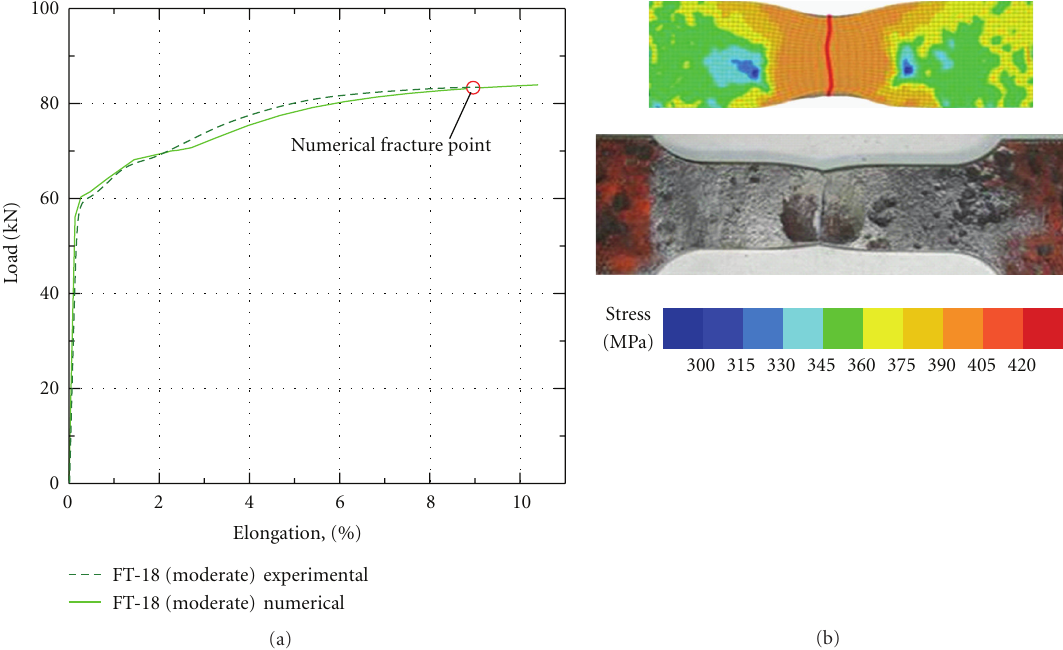
Figure 6: (a) Comparison of experimental and analytical load-elongation curves and (b) stress distribution at ultimate load for the moderate corrosion member